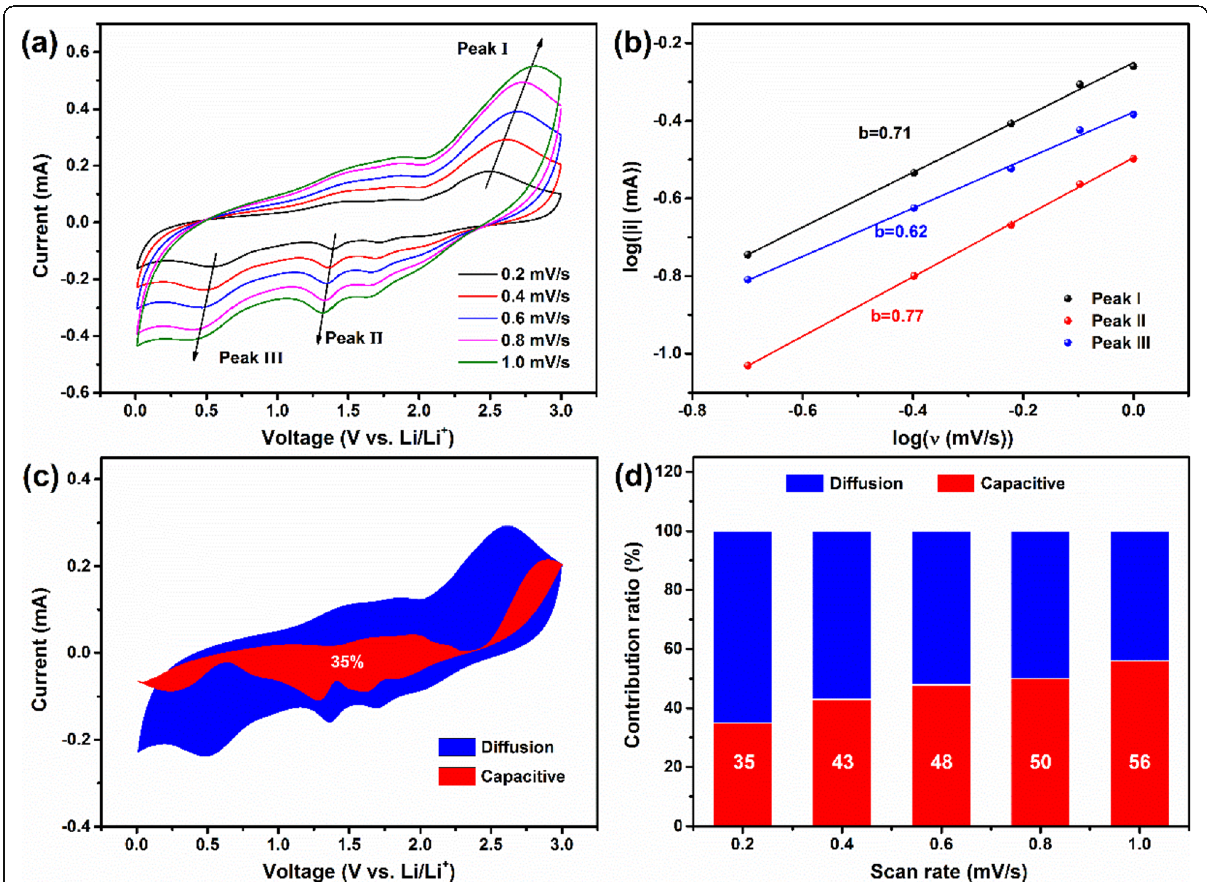
Fig. 7 a CV curves of CoSe/NC after 100 cycles at 0.2 to 1.0 mV s − 1 . b Plots of log ν versus log |i| for the three peaks in CV curves. c Capacitive and diffusion-controlled contribution to charge storage at 0.2 mV/s. d Contribution ratio of capacitive and diffusion-controlled capacities at 0.2 to 1.0 mV s −